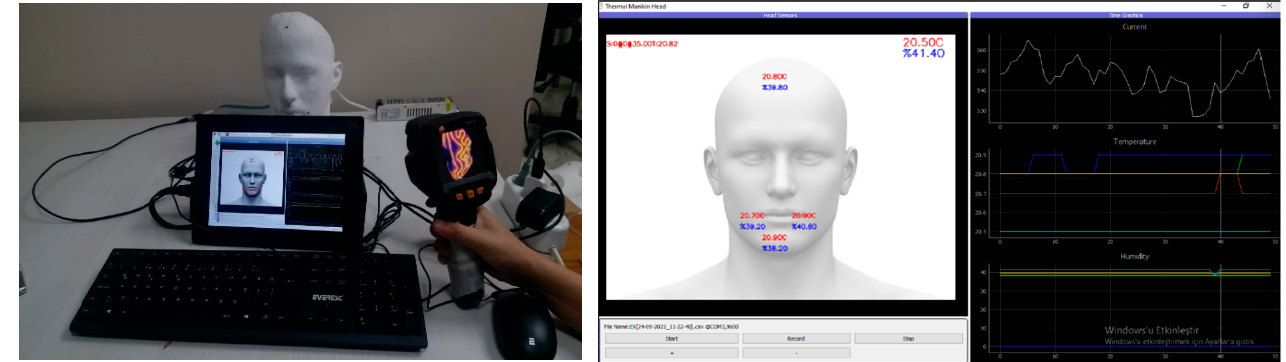
Figure 4. The images of the thermal head model measurement system and graphical user inter- face.